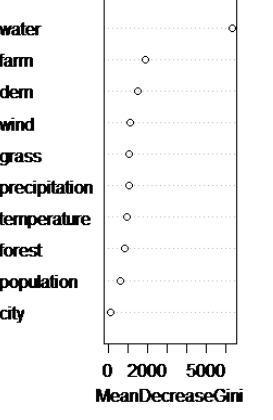
Figure 6. Importance of socio-ecological variables.